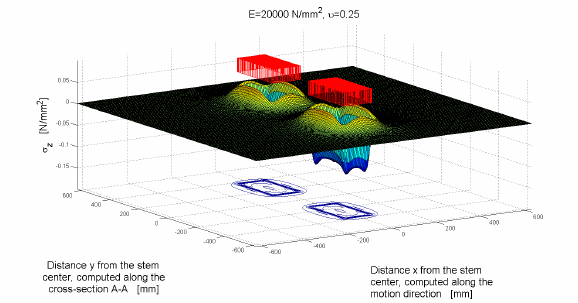
Figure 31: 3-D surfaces and stress contours of σ z near the surface for the interaction model of Figure 28 (second order solution).